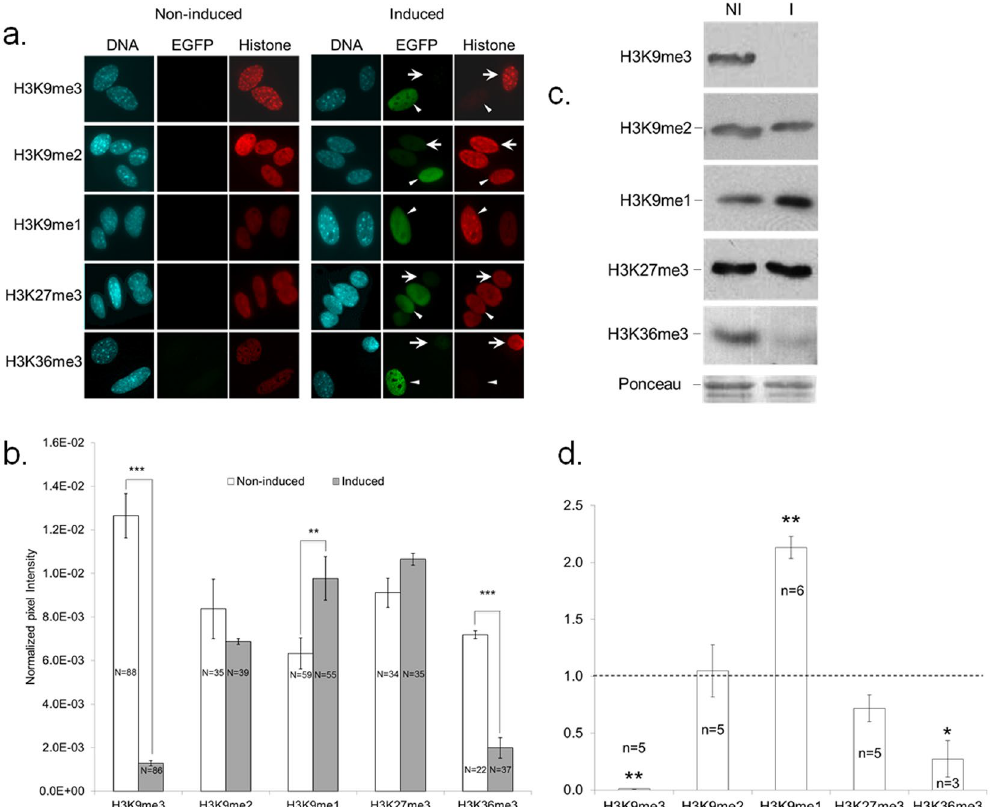
Figure 2. Characterization of histone methylation in Kdm4b -EGFP expressing MEFs. ( a ) Immunofluorescence of histone modifications in non-induced (NI) vs induced (I) MEFs. Cells were co-stained for EGFP and histone modification antibodies. Arrowheads and arrows indicate EGFP-positive and –negative nuclei, respectively. ( b ) Quantification of global histone methylation in NI vs I MEFs. Values represent normalized pixel intensity ± SEM. Asterisks indicate significant differences. N = number of nuclei quantified, RU = relative units; *** P < 0.001; ** P < 0.01. ( c , d ) Kdm4b -dependent changes in levels of H3K9 methylation states. ( c ) Histone extracts from NI vs I MEFs were quantified for the indicated histone modifications by western blot. Shown are cropped representative blots for the different methyl states of H3 and a cropped representative Ponceau staining. ( d ) Quantification of western analysis. Results represent H3 methylation levels in induced cells as a percentage of non-induced levels ± SEM. Dotted line indicates NI level; n = number of replicate experiments, Bars with an asterisk differ from NI level at ** P < 0.005, * P < 0.05, as determined by two–tailed paired t-test on normalised band